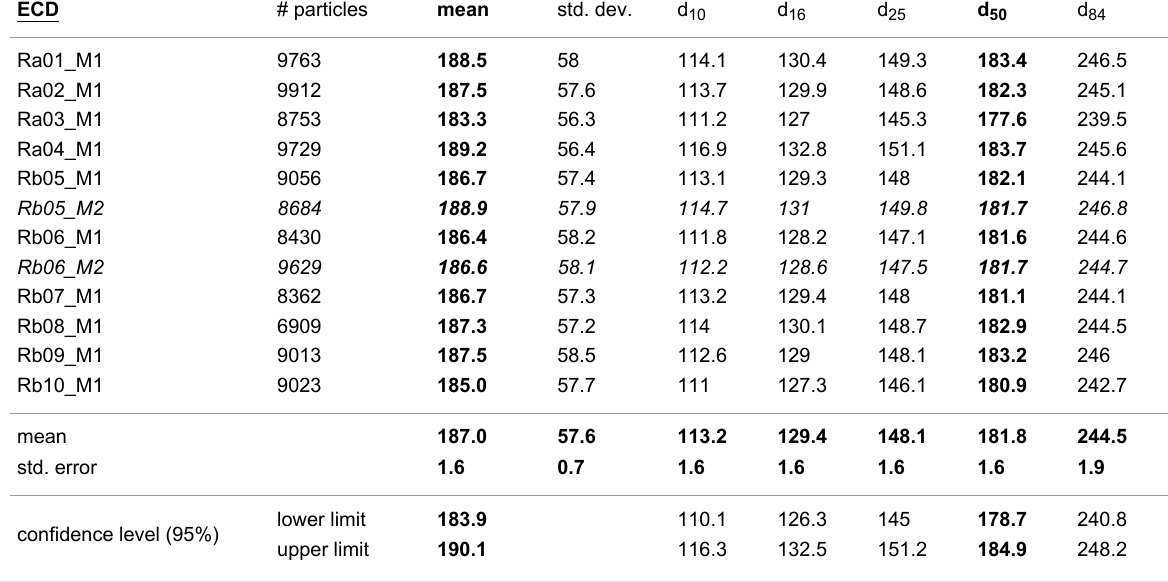
Table 1: Evaluation of the primary particle sizes of KRONOS K2360 in terms of the equivalent circle diameter (ECD); all values given in nm. ECD # particles mean std.